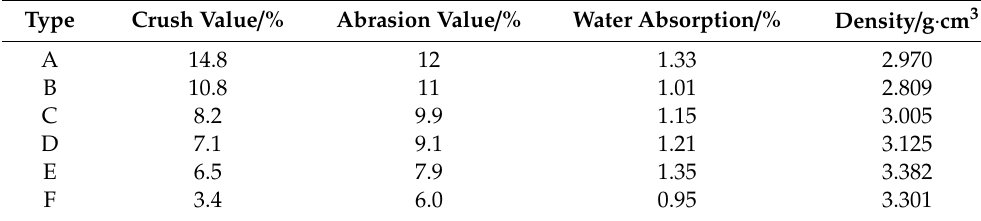
Table 3. Technical properties of di ff erent types of